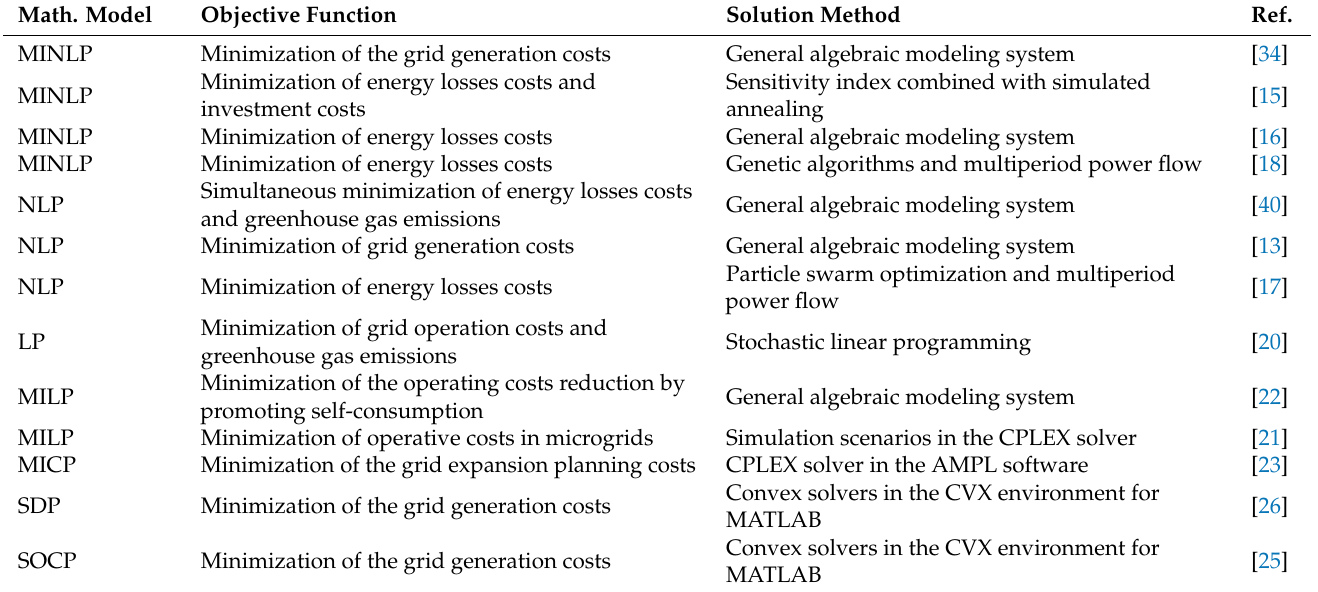
Table 1. Main approaches reported in the specialized